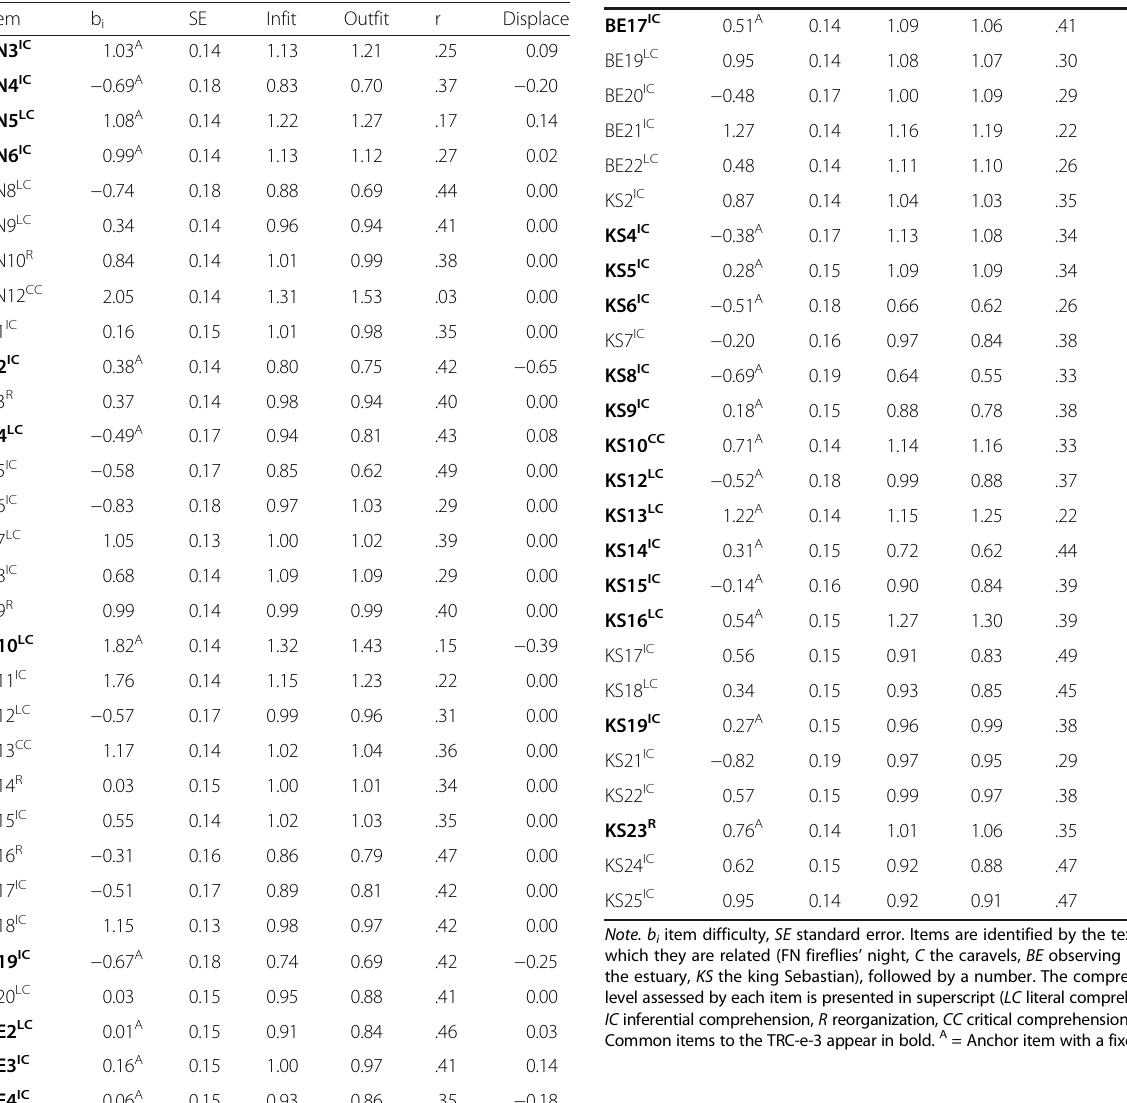
Table 7 Psychometric properties of the items of the